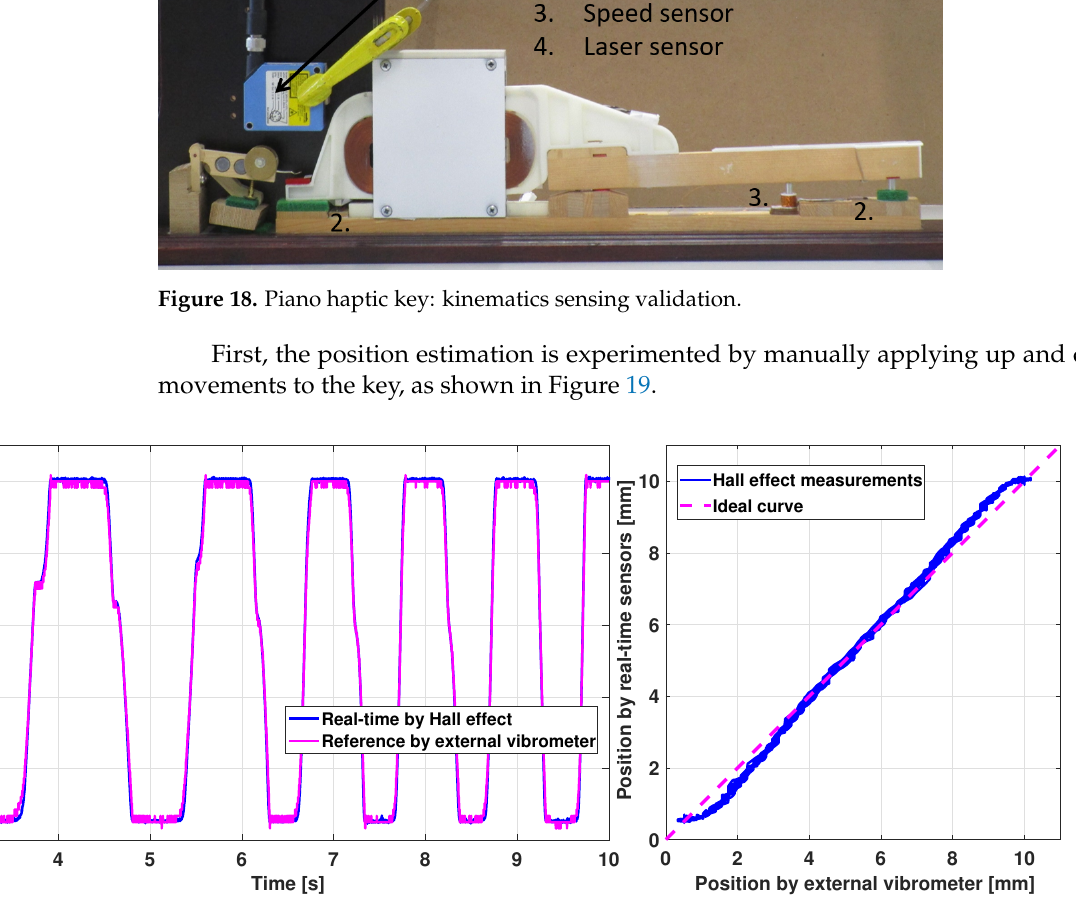
Figure 19. Haptic key validation of position sensors: slow